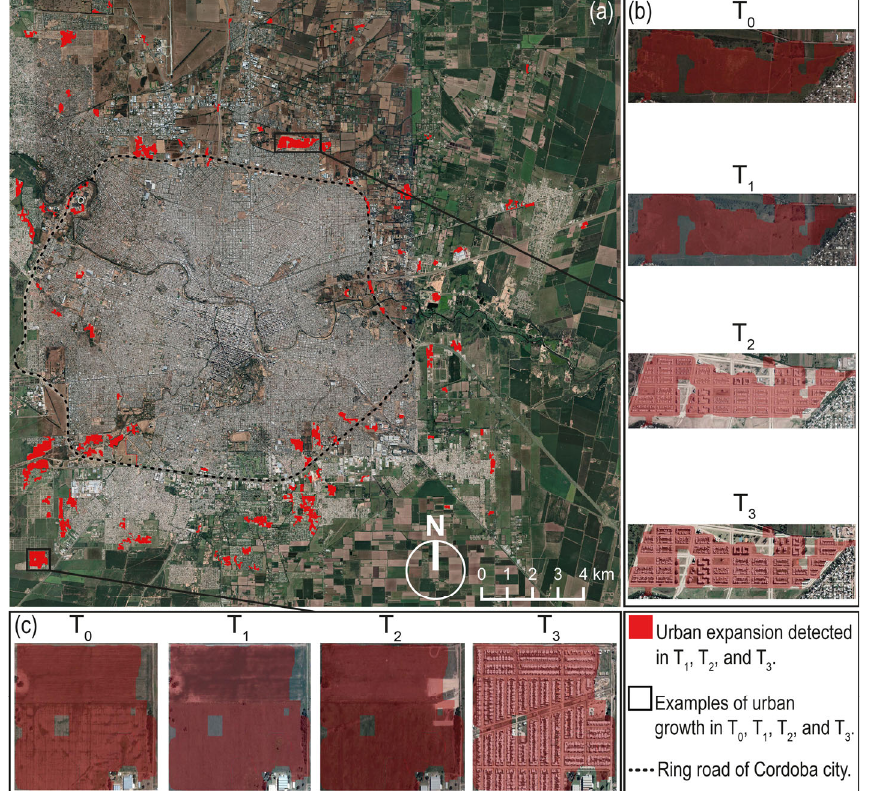
Figure 4. Urban expansion map summarizing changes that occurred during the entire timeframe 2010–2021 across the overall metropolitan area ( a ) and on two zoomed areas reporting examples of expansion processes. ( b ) UrbExp T2 ( c ) UrbExp T3 .